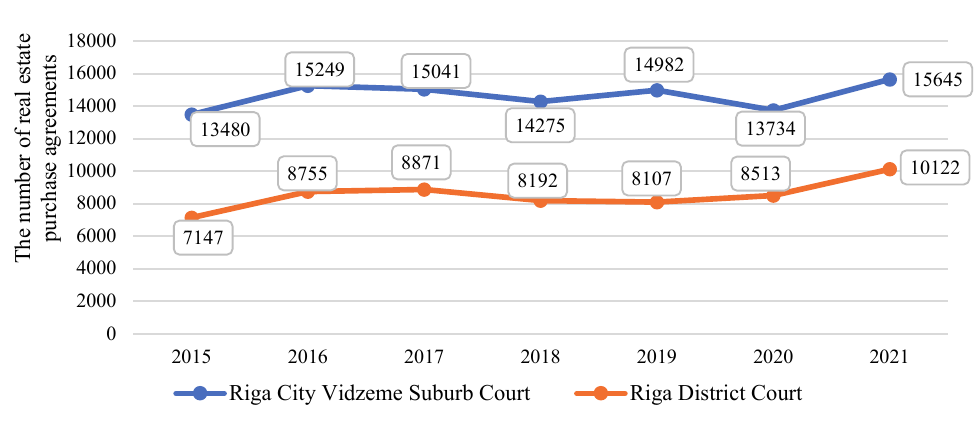
Fig. 11. The number of purchase agreements in Riga (Riga City Vidzeme Suburb Court) and Riga District (Riga District Court) from 2015 to 2021 (developed by the authors based on the State Unified Computerized Land Register). Note: Riga District =